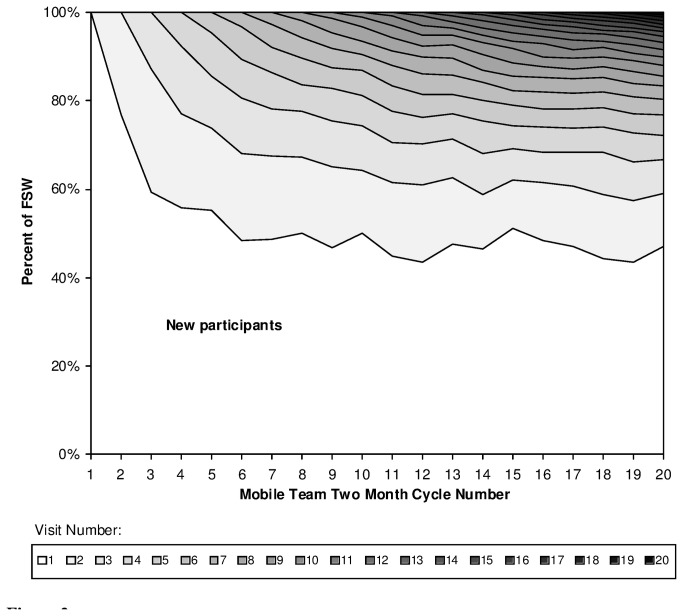
Proportion of female sex workers new to Mobile Teams at each intervention cycle.For each cycle, the number of encounters decreases from top to bottom of the figure; participants with greatest number of Mobile Team encounters are depicted at the top, those with lowest (i.e., new participants) at the bottom.